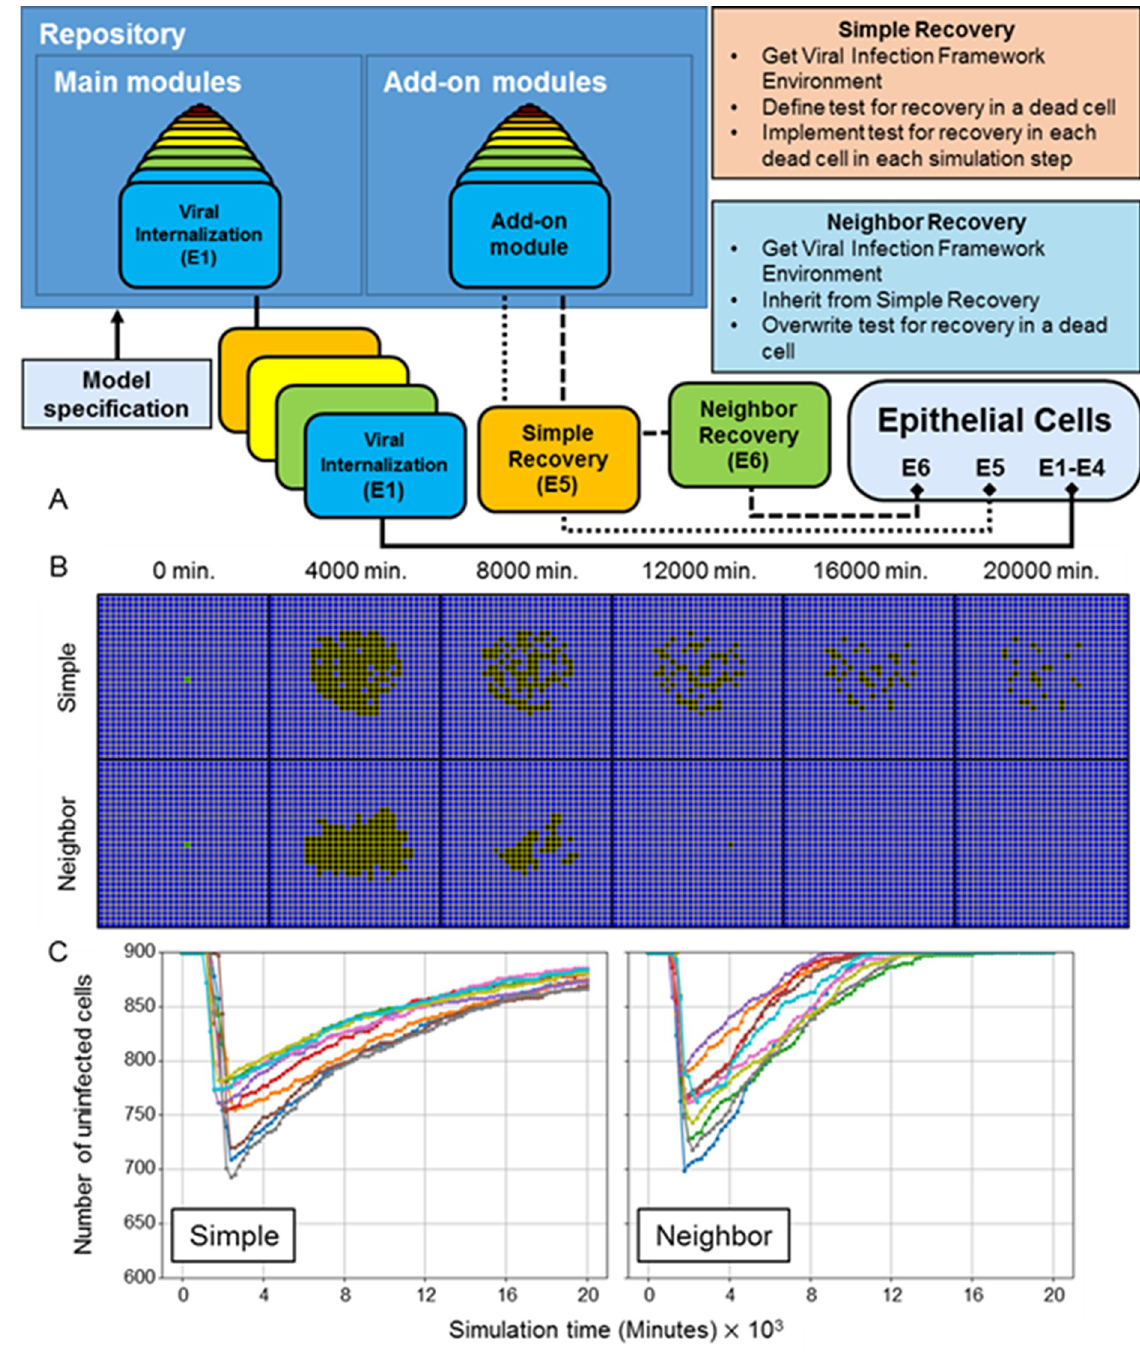
Fig 14. Even simple model extensions and extensions of extensions can produce notably different spatiotemporal emergent features. (A) Schematic of implementing a modified epithelial cell model using the available modules described in Models and methods (“Main modules”) and add-on modules libraries hosted in the framework public repository. Modules used in a simulation are specified in model specification. The Simple Recovery and Neighbor Recovery model modules are available in the add-on modules library. (B) Distribution of epithelial cells during simulation time using the Simple Recovery (top) and Neighbor Recovery (bottom) models. Cell type colors are the same as in Fig 3A. (C) Number of uninfected cells during simulation time for ten simulation replicas using the Simple Recovery (left) and Neighbor Recovery (right)